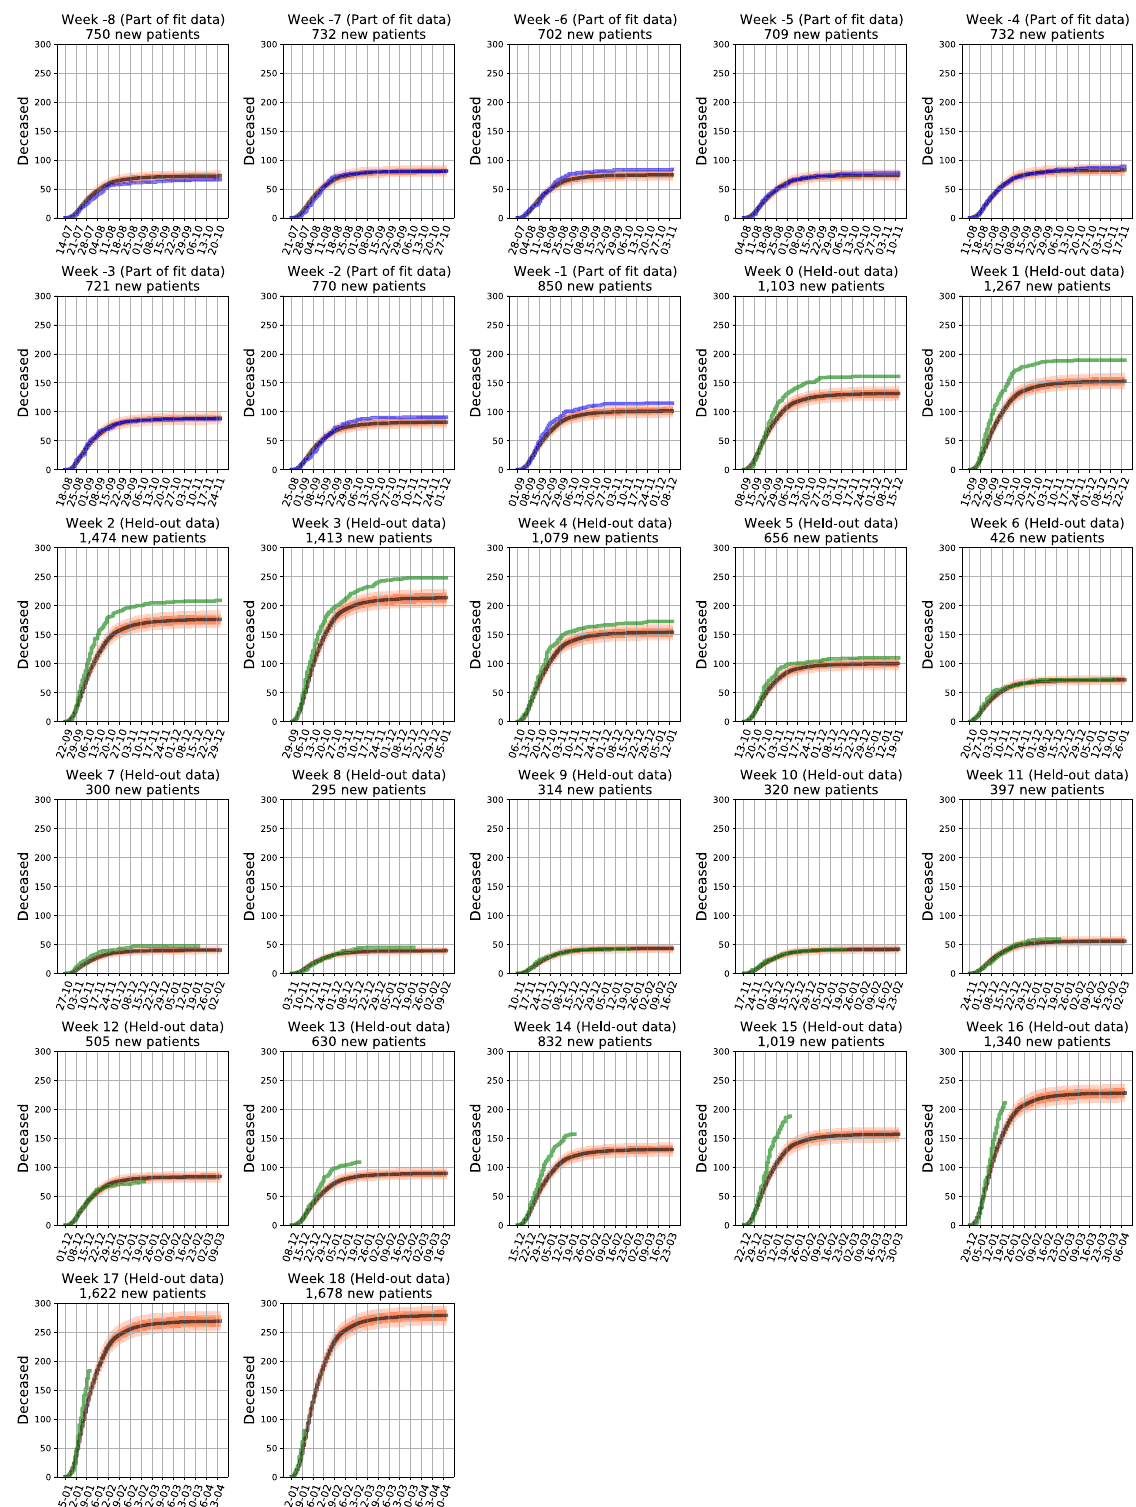
Fig. 2 Cumulative expected and observed COVID-19 in-hospital deaths by week of fi rst hospitalization. Each sub- fi gure presents curves for the set of patients fi rst hospitalized in a given week. Black curves are expected deaths with orange bands representing Monte-Carlo-based pointwise 10 – 90% con fi dence predictions. Blue and green curves are actual deaths for weekly sets of patients. Blue curves are drawn for patients which the model was trained on (weeks − 8 to − 1), and green curves are drawn for patients which the model was not trained on (weeks 0 –